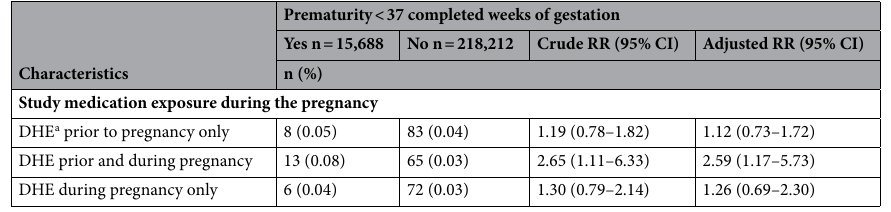
Table 7. Association between DHE exposure before or during pregnancy and the risk of prematurity by categories of DHE exposure. Adjusted for all variables included in Table 1. a Dihydroergotamine.